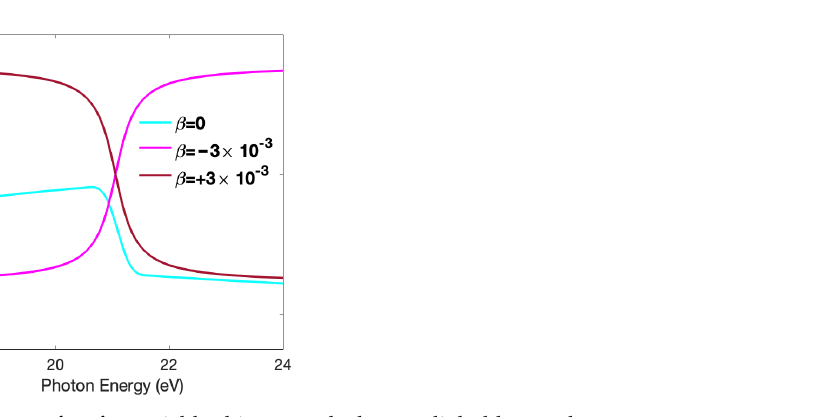
Figure 5. Phase of φ 2 for variable chirp rate: the brown, light blue, and magenta curves represent the phase for β = 0, + 3 × 10 − 3 and − 3 × 10 − 3 ,